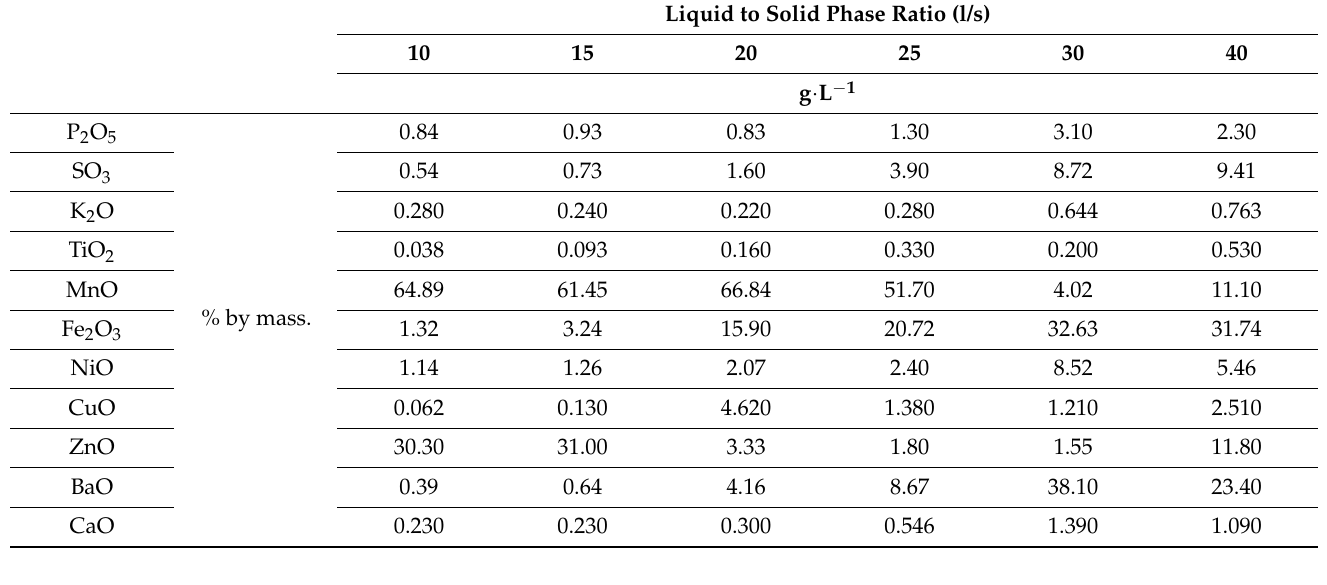
Table 4. Chemical composition of solid residues as a result of non-selective leaching of black mass.